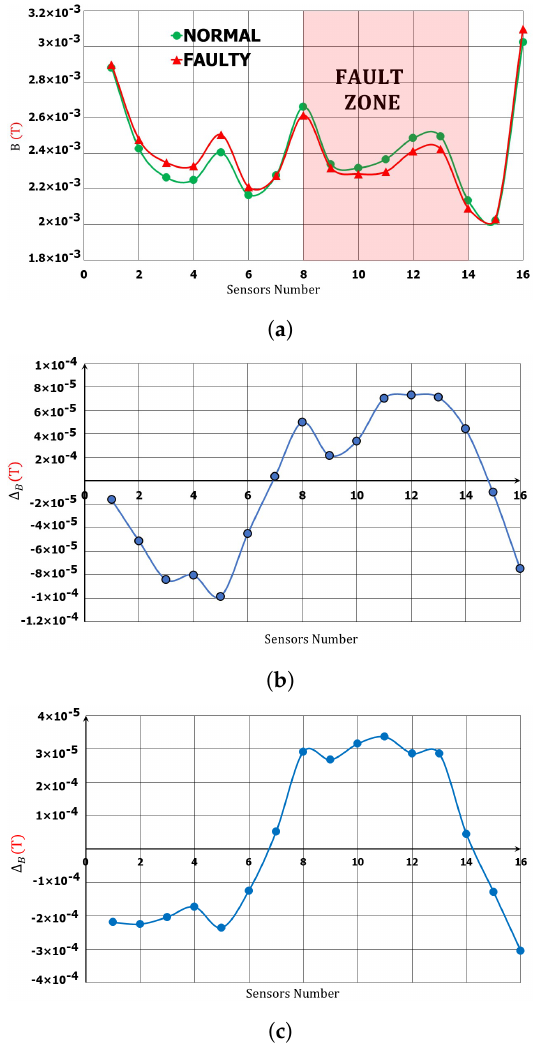
Figure 9. Experimental representation for ( a ) normal and fault passivated FC emulator, with ( b ) the fabricated 3D ∆ B and ( c ) 2D ∆ B produced by 16 bars